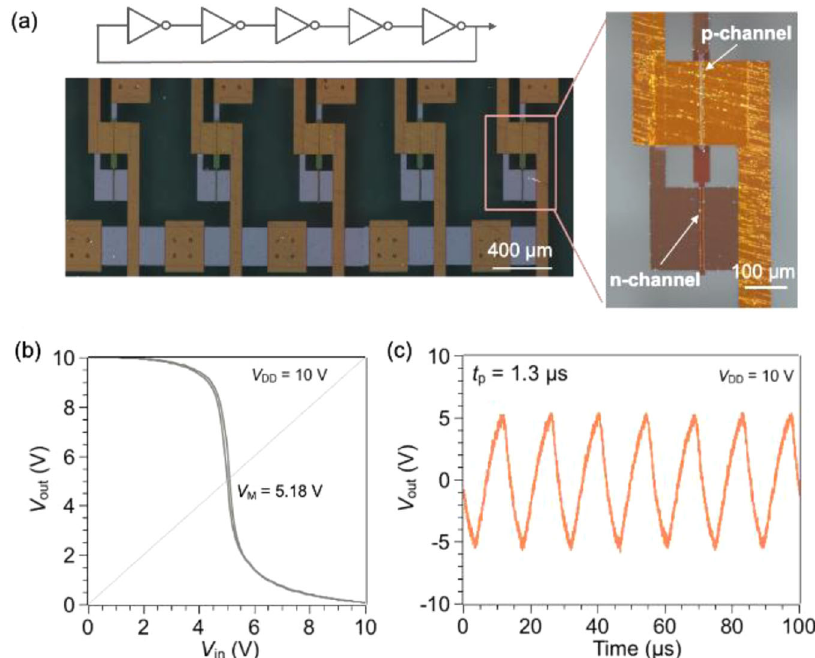
Fig. 6 Properties of a fi ve-stage ring oscillator. a Optical micrograph of a hybrid ring oscillator. The magni fi ed image shows one stage. W / L = 200 µ m/ 4 µ m and Δ L = 3 µ m for p-channel TFT and W / L = 200 µ m/8 µ m and Δ L = 1.5 µ m for n-channel TFT, where Δ L is the gate overlap. b VTCs of the hybrid inverter with V DD = 10 V. c Output signal of the ring oscillator at V DD = 10 V.